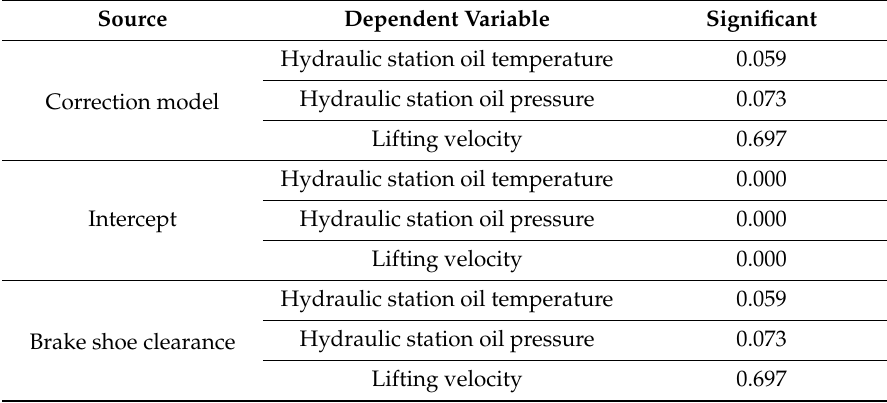
Table 2. Inter-subjective e ff ect test